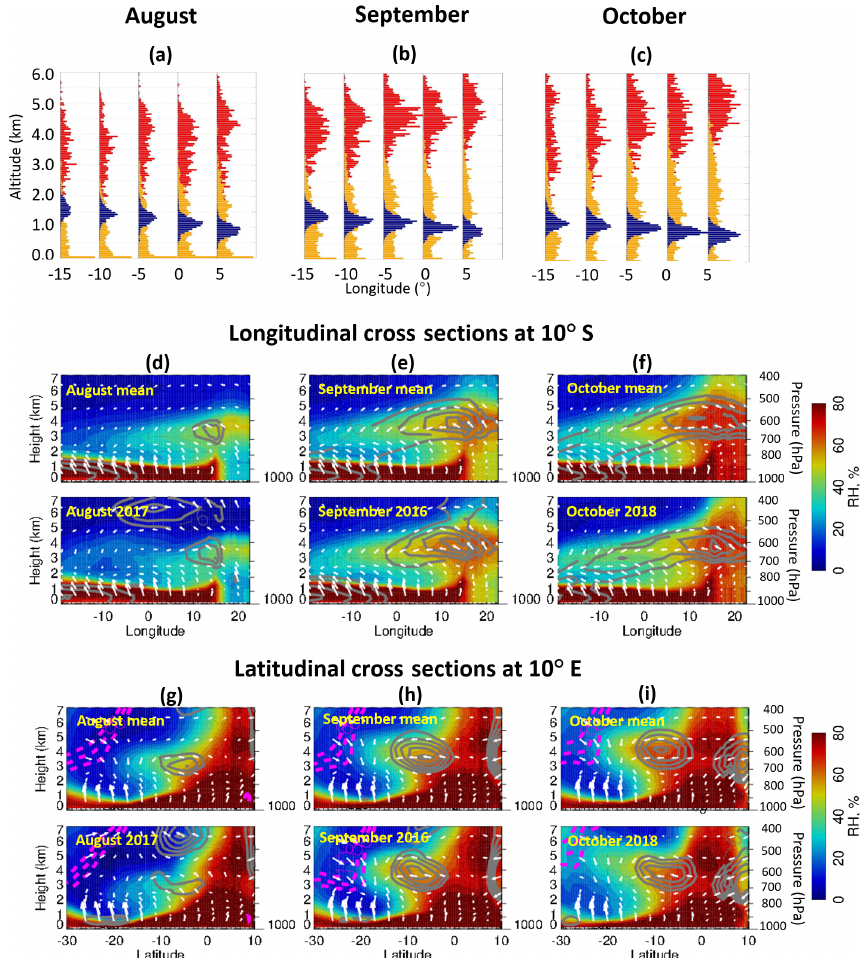
Figure 2. (a–c) Distributions of the climatological mean (2006–2017) aerosol layer top height (red), cloud top height (blue), and the sep- aration distance between clouds and overlying aerosols (yellow) as a function of longitude (latitudinally averaged from 10–22.5 ◦ S) from Cloud–Aerosol Lidar with Orthogonal Polarization (CALIOP). Source: figure reproduced from Redemann et al., 2021. (d–f) The longitu- dinal cross sections at 10 ◦ S and (g–i) latitudinal cross sections at 10 ◦ E of the RH (shading; percent) overlain by zonal wind (contours are solid gray lines; easterly lines are magenta dashed; westerly lines are in ms − 1 ) during (top) climatological mean (2000–2018) and (bottom) the 3 years of deployment months (August 2017, September 2016, and October 2018). White arrows represent the horizontal wind